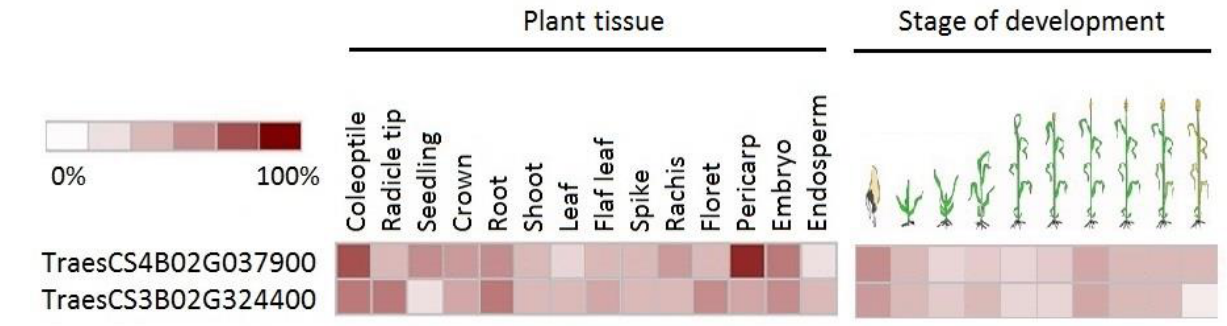
Figure 7. Transcript expression pattern for TraesCS4B02G037900 (bread wheat homolog of durum wheat is TRITD6Bv1G045800 , coding for Lipoxygenase 2) and TraesCS3B02G324400 (bread wheat homolog of durum wheat is TRITD3Bv1G171000 , coding for WRKY transcription factor). Expres- sion is presented as a heat map in different plant tissues and during different stages of develop- ment during the lifecycle of bread wheat on publicly available expression data (www.genevestigator.com (accessed on 1 June 2022)).